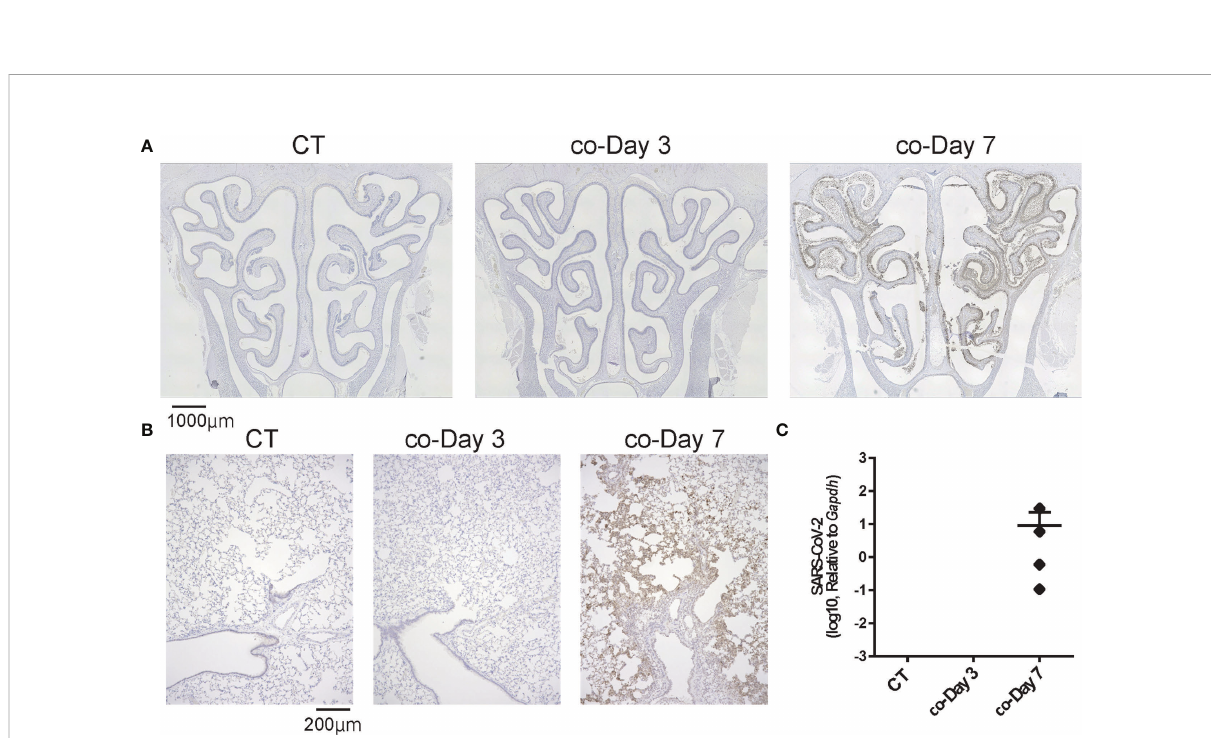
FIGURE 3 Representative SARS-CoV-2 infection fi ndings in the nose and lungs after short-term close contact with SARS-CoV-2 infected animals. (A, B) Representative images of SARS-CoV-2 staining in the nose (A) and lungs (B) 3 and 7 days after short-term close contact with SARS-CoV-2 infected animals (co-Day 3, co-Day 7). The number of each type of cell in a 300- m m region of each area was counted in the right and left sides of each sample (n = 4, each group). (C) SARS-CoV-2 gene detection with RT- quantitative polymerase chain reaction in the CT hamster and contact hamsters on days 3 and 7. SARS-CoV-2, severe acute respiratory syndrome coronavirus